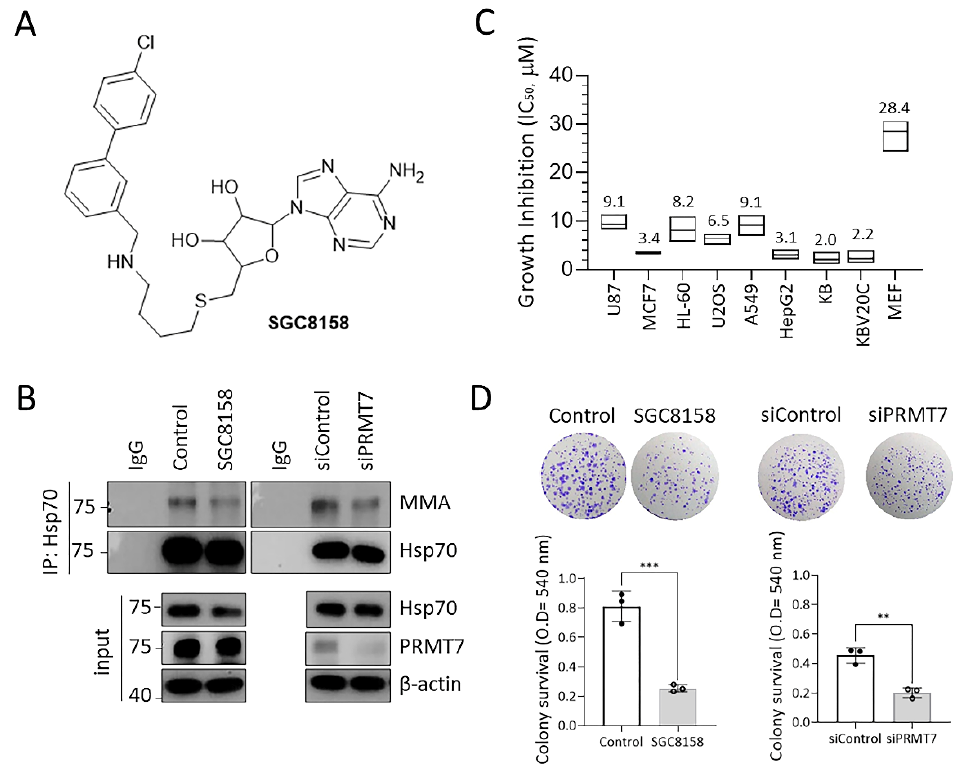
Figure 1. PRMT7 inhibition causes growth inhibition in various human cancer cells. ( A ) Structure of SGC8158 ( B ) A549 cells were treated with 10 µ M SGC8158 or transfected with PRMT7 siRNA for 3 days. Whole-cell lysates were subjected to immunoprecipitation using Hsp70 antibody, followed by immunoblotting with MMA antibodies. ( C ) The growth inhibition of SGC8158 in various human cancer cells was determined using an MTT assay. Data are presented as floating bar plots from three independent experiments. ( D ) A549 cells were treated with 10 μ M SGC8158 or transfected with PRMT7 siRNA as described. After five days, the colonies were stained using crystal violet (10× mag ‐ nification) and the absorbance was measured at 540 nm. Data are presented as means ± SD ( n = 3). ** p < 0.01 and *** p < 0.001. MMA: monomethylarginine; MTT: 3 ‐ (4,5 ‐ dimethylthiazol ‐ 2 ‐ yl) ‐ 2,5 ‐ di ‐ phenyltetrazolium bromide; SD: standard deviation.